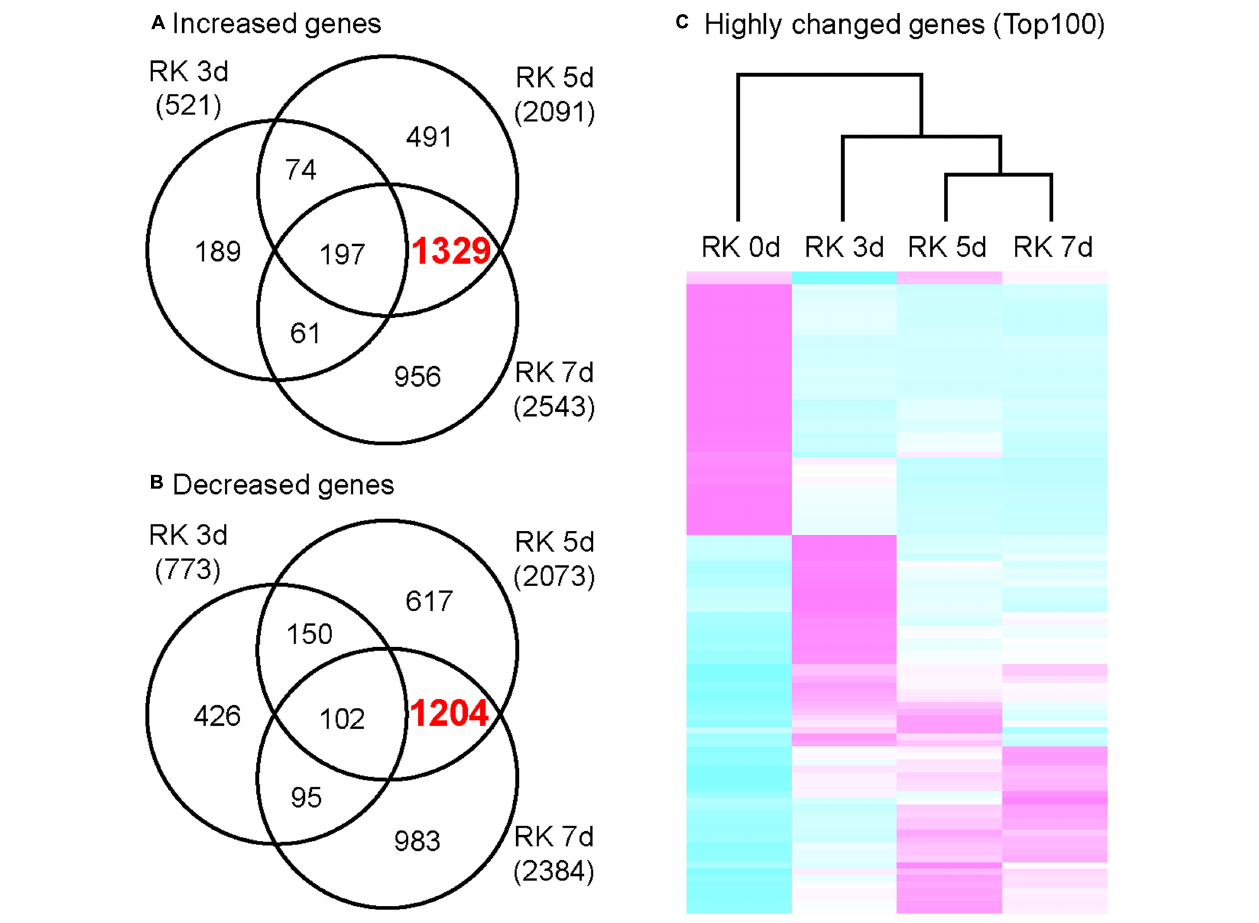
FIGURE 2 | Transcriptome analysis of growing galls in the in vitro assay system. Venn diagrams that depict the number of genes increased (A) and decreased (B) in galls. Genes shown here all show at least twofold changes in expression relative to non-treated roots. (C) Comparison of differentially expressed genes that were determined by top 100 of FDR value. Magenta indicates genes increased compared to median levels of the four samples, whereas cyan means decreased amount of